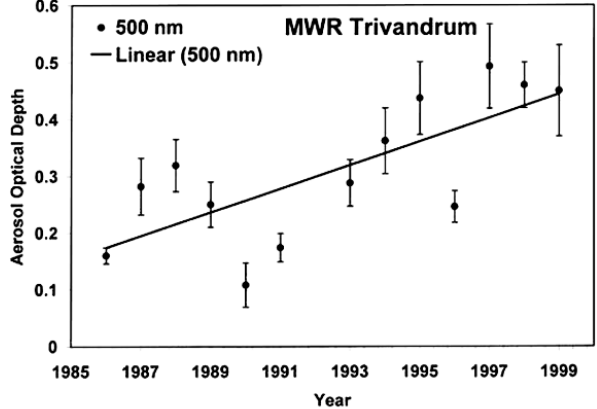
Fig. 33. Long-term variations in aerosol optical depth from 1986 to 1999 measured above Trivandrum; plotted are annual mean values with standard deviations determined from the monthly means (from Satheesh et al., 2002, copyright 2002 by the American Geophysical Union, reproduced with